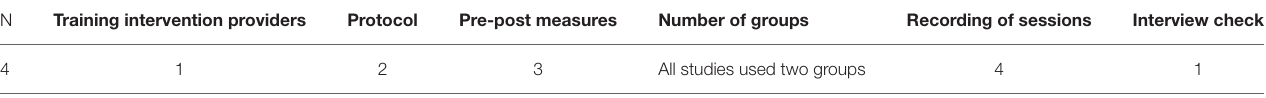
TABLE 1 | Compliance with EBI controls by the four intervention studies.